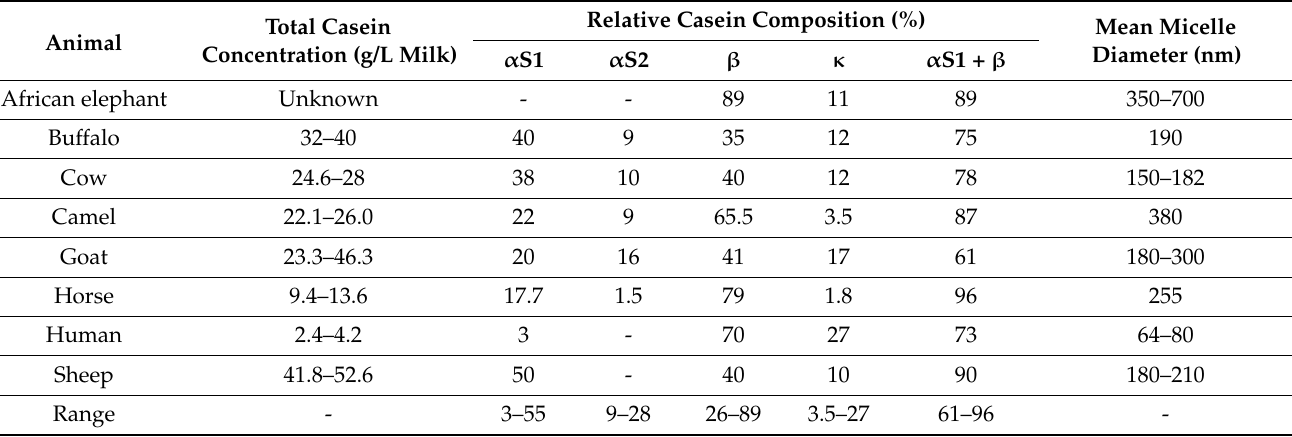
Table 1. Casein composition and micelle size of milks from humans and selected mammalian species